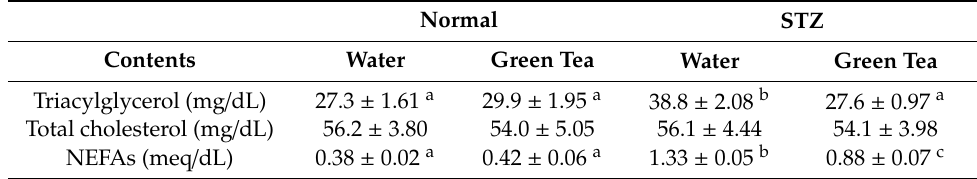
Table 1. Green tea ameliorated abnormalities in plasma lipid concentrations in STZ-induced T1DM rats. Normal STZ